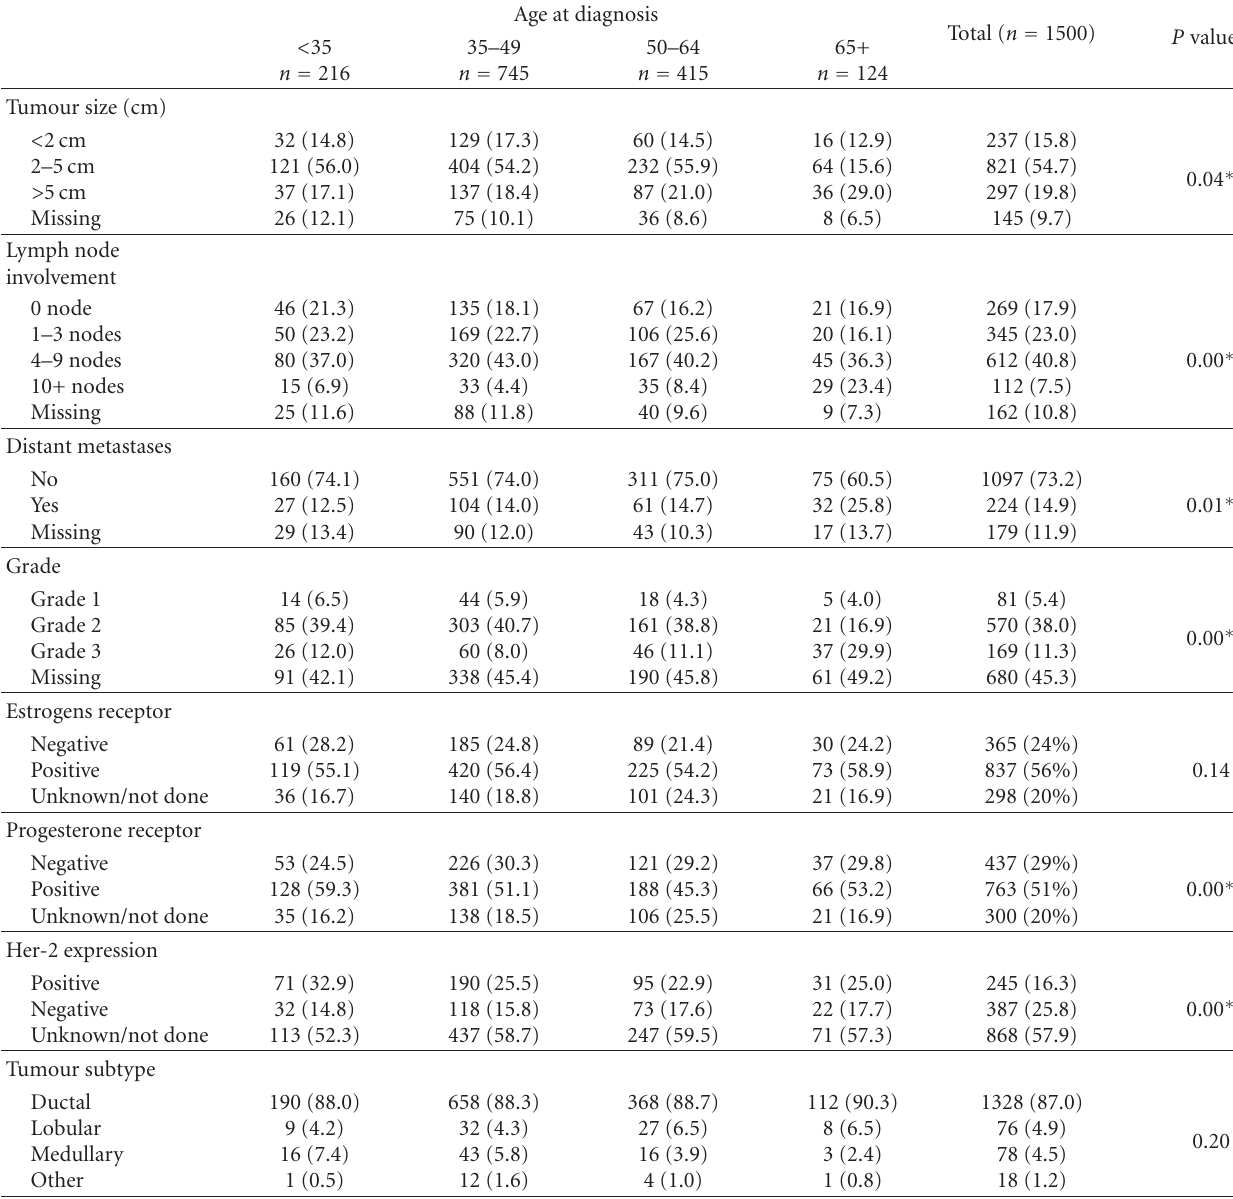
Table 2: Tumour characteristics of breast cancer patients in Iran diagnosed in the period of 1999–2001.